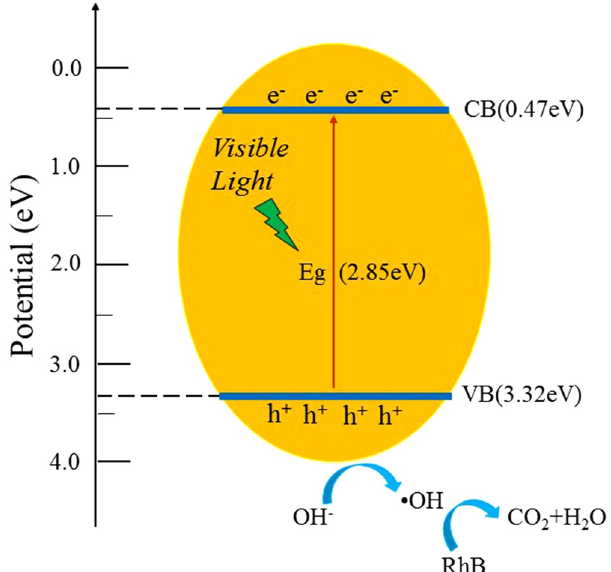
Figure 11. Photocatalytic mechanism of the as-prepared porous monoliths of MoO 3